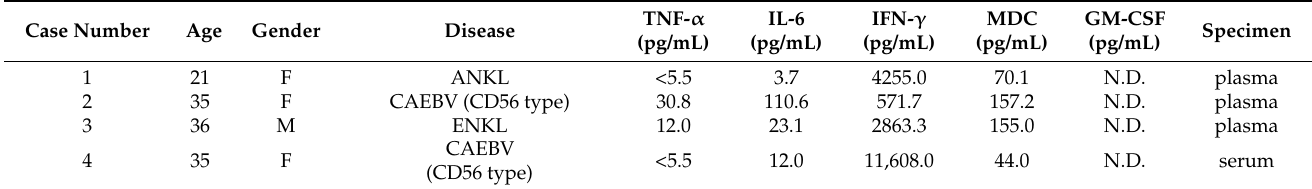
Table 1. The concentration of the inflammatory cytokines in the blood of the EBV-positive NK-cell neoplasms accompanied by